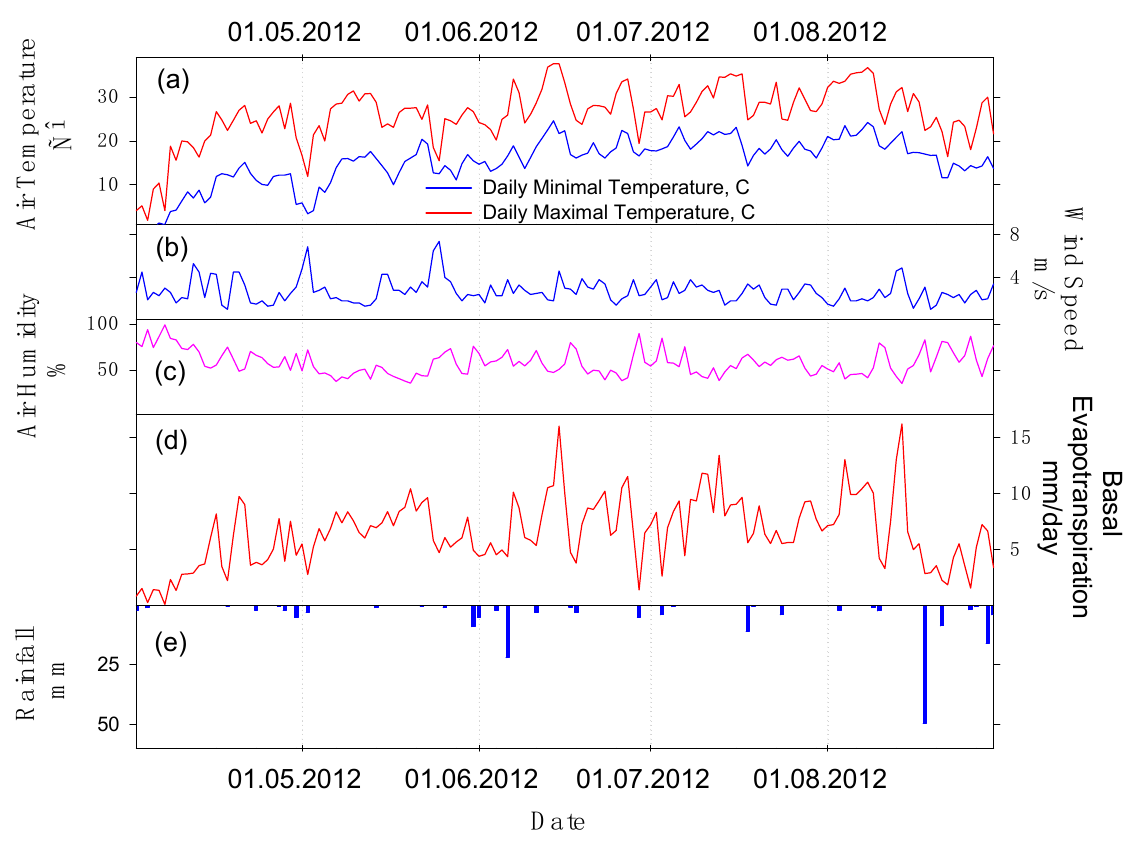
Figure 2. Agrometeorological characteristics of Marks town meteorological station: ( a ) air tempera- ture; ( b ) wind speed; ( c ) air humidity; ( d ) basal evapotranspiration; ( e ) rainfall.